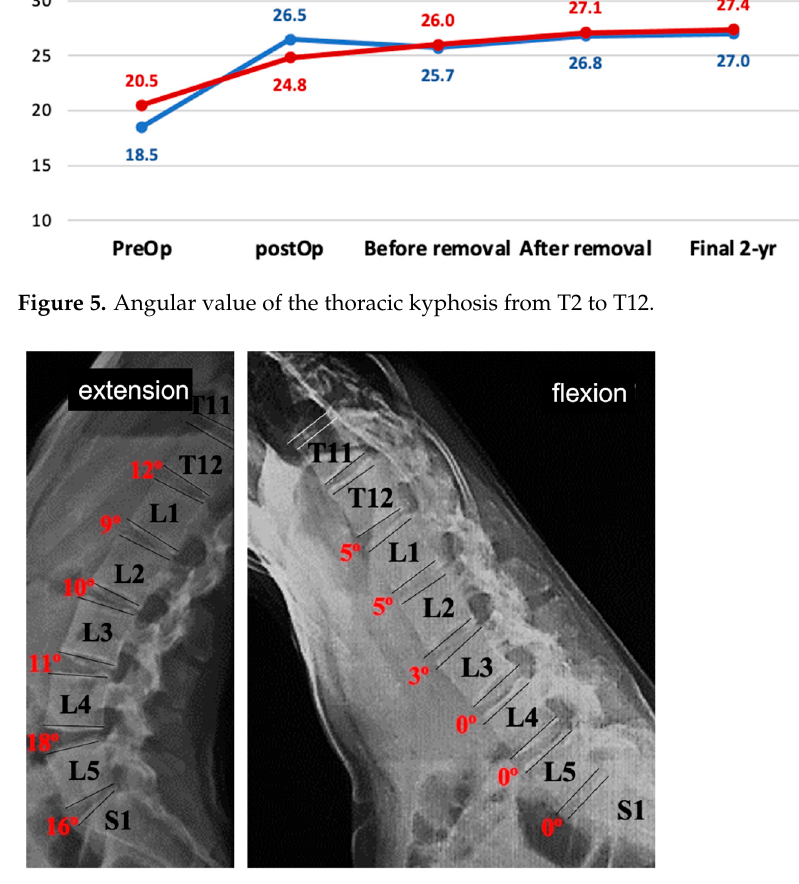
Figure 6. Fourteen-year-old girl with AIS type 1CN Lenke (54° Cobb) who underwent correction surgery with T3–L3 instrumentation. The images show the sagittal X-rays of the lumbar spine in maximal extension and flexion after removal of the implants.